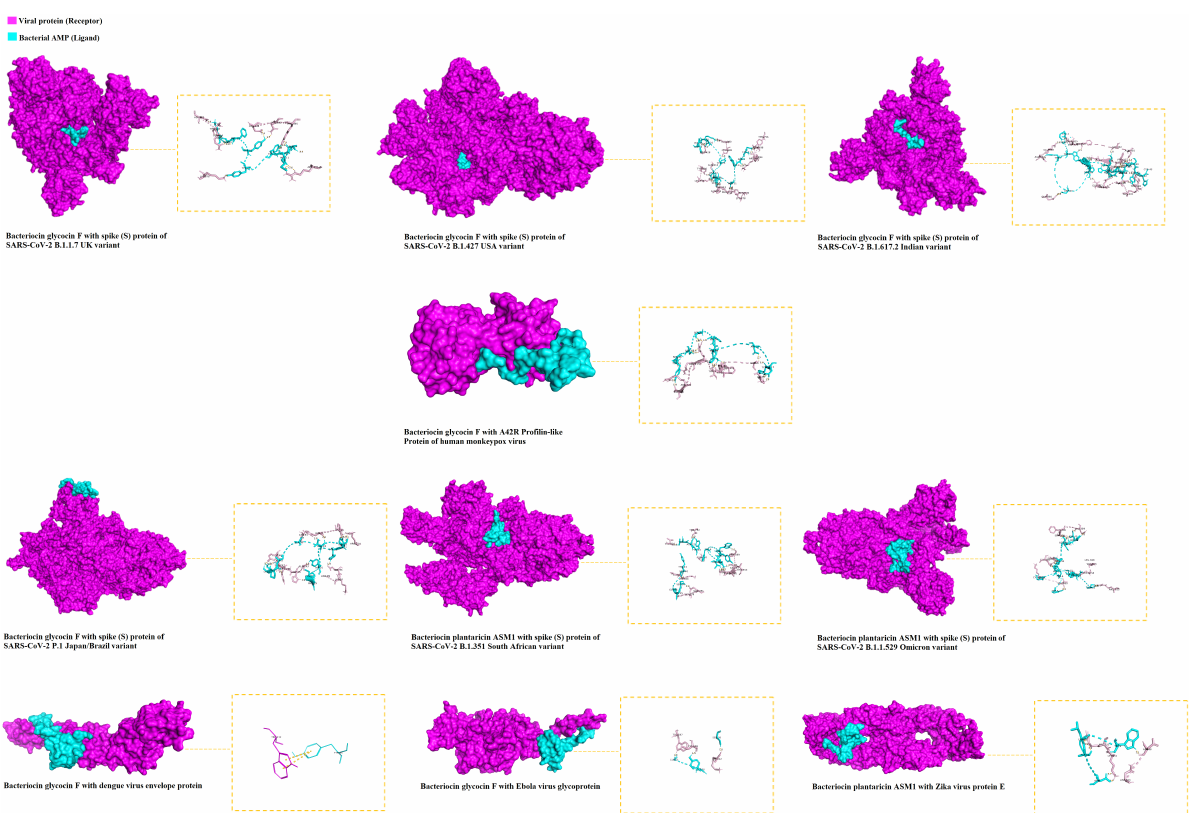
Figure 1. The 3D visualization of the molecular docking of bacterial AMPs with viral surface proteins and their corresponding amino acid residues (highest binding affinities between AMPs and each viral protein were selected). The viral protein (receptor) is illustrated in purple and the bacterial AMP (ligand) is illustrated in